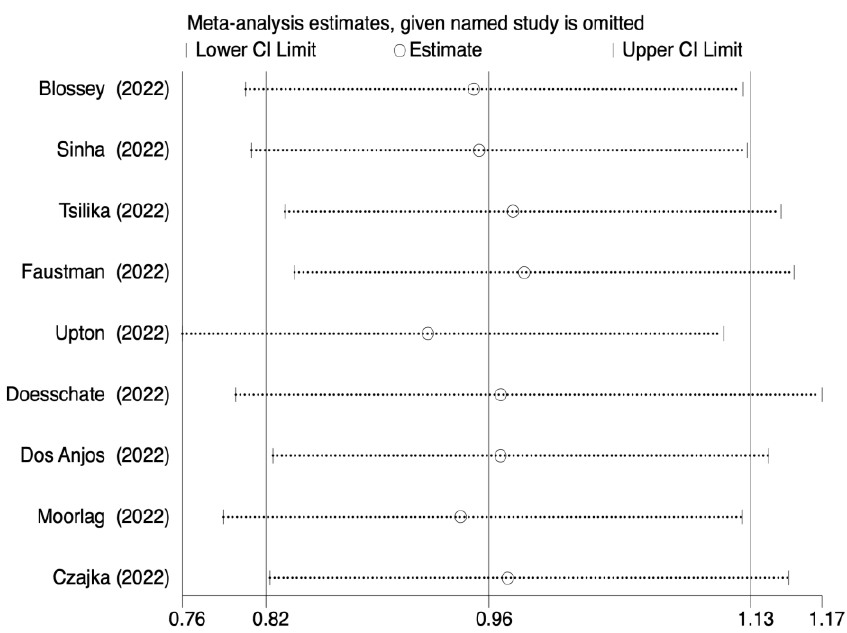
Figure 3. Sensitivity analysis result of the association between BCG vaccination and incidence of COVID-19.